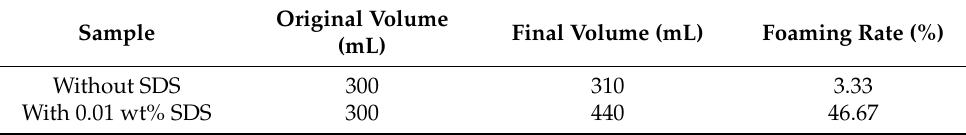
Table 1. Foaming rate of different PSL rubber nanogels in mineral oil.